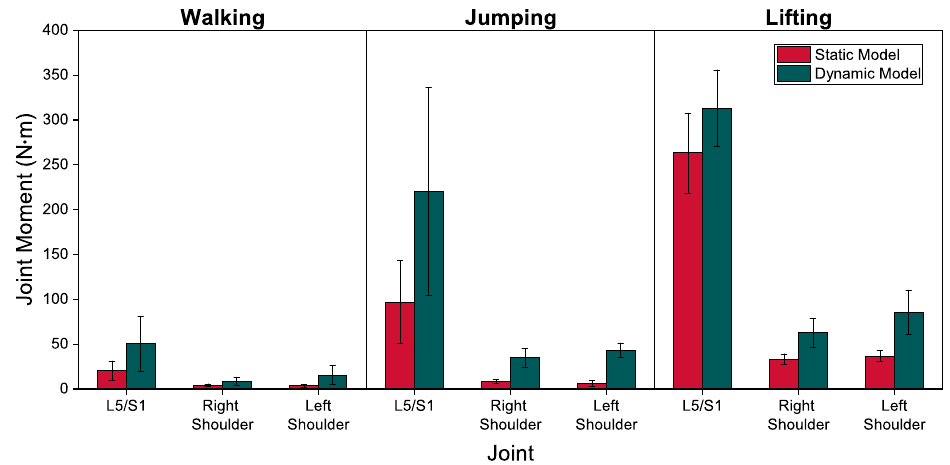
Figure 12. Average peak of the net moments of L5/S1, right, and left shoulder joints predicted by static (red bars) and dynamic (dark-green bars) models during walking, jumping, and lifting.